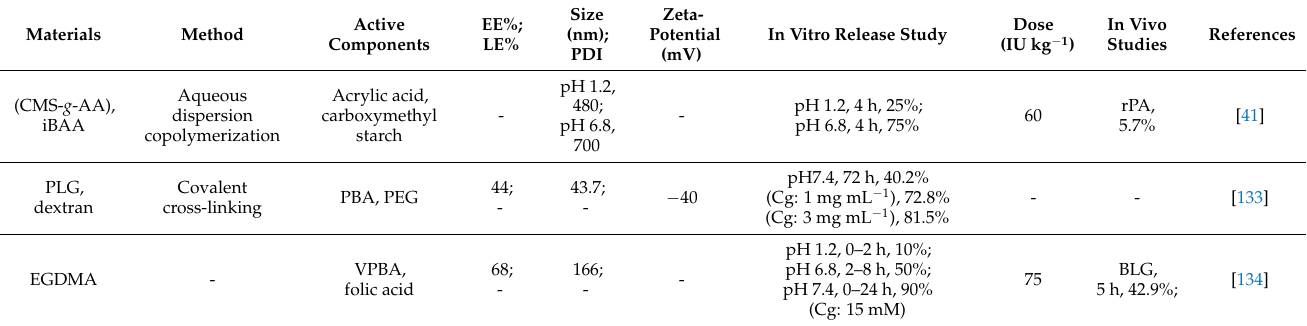
Table 7. Examples of nanogel as a nanostructure for oral insulin delivery